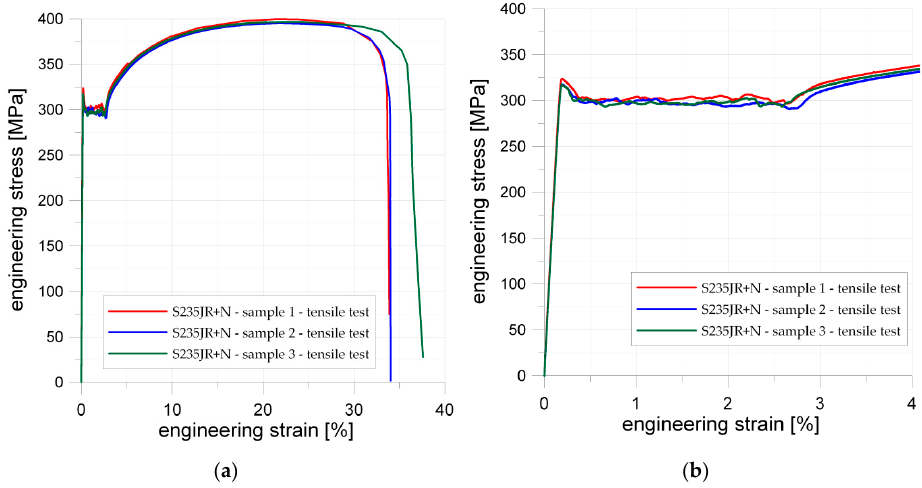
Figure 8. Tensile behavior of S235JR + N: ( a ) engineering σ – ε curves for tested specimens; and ( b )